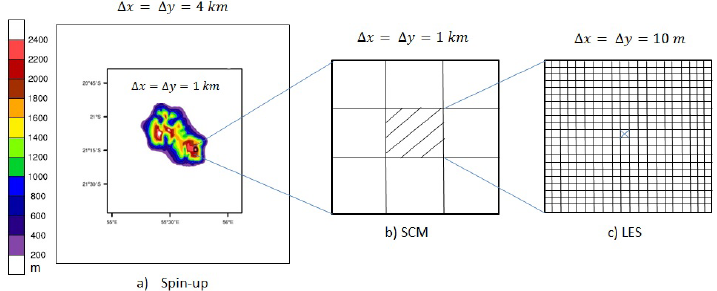
Figure 4. The interconnection in terms of the simulation domain between the three sets of simulations performed: Spin-up, SCM and LES. The single cell corresponding to the fissure is tagged for